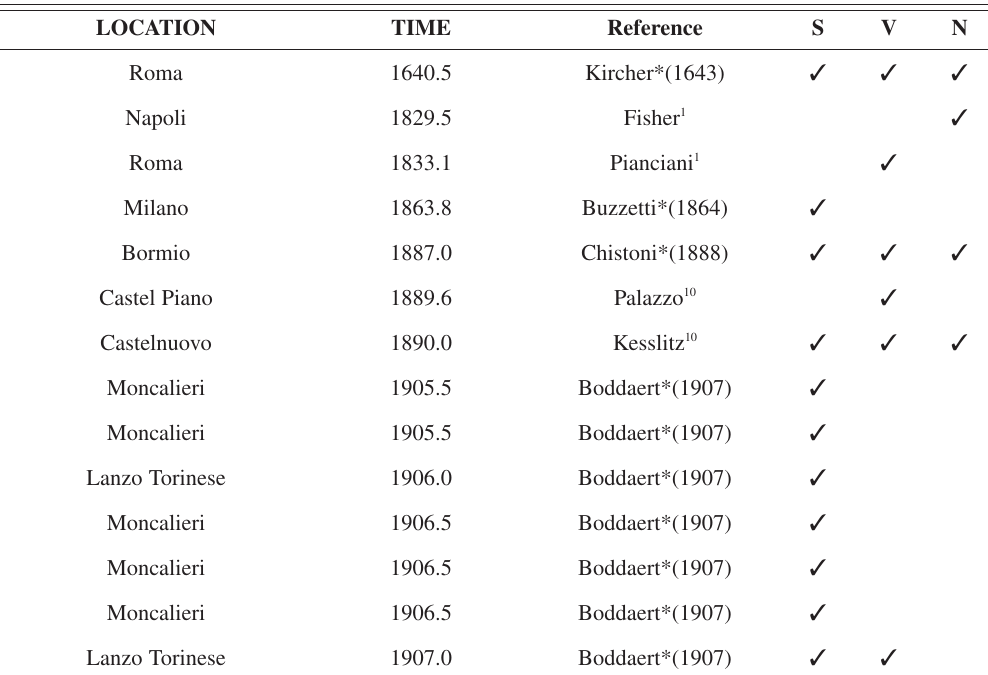
Table I. Directional data from the Historical Italian Geomagnetic Data Catalogue (Cafarella et al. , 1992a) that fail to lie below the line of assumable relocation error for at least one of the three relocation centres: La Spezia (S), Viterbo (V) or Naples (N). Failure is indicated by ✓ sign. References are labelled according to Cafarella et al.